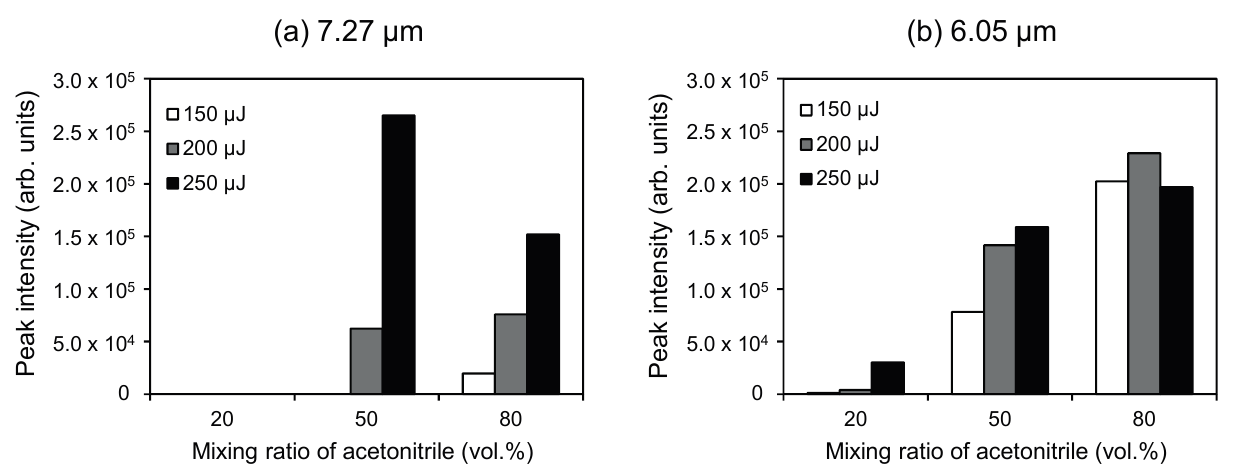
Figure 6. Relationships between the ion signal intensity of [M + H] + of angiotensin II and the mixing ratio of acetonitrile in an aqueous solvent with laser wavelengths of ( a ) 7.27 µm and ( b ) 6.05 µm. The electric potential of the frit and the capillary temperature were set to 2.5 kV and 270 °C,